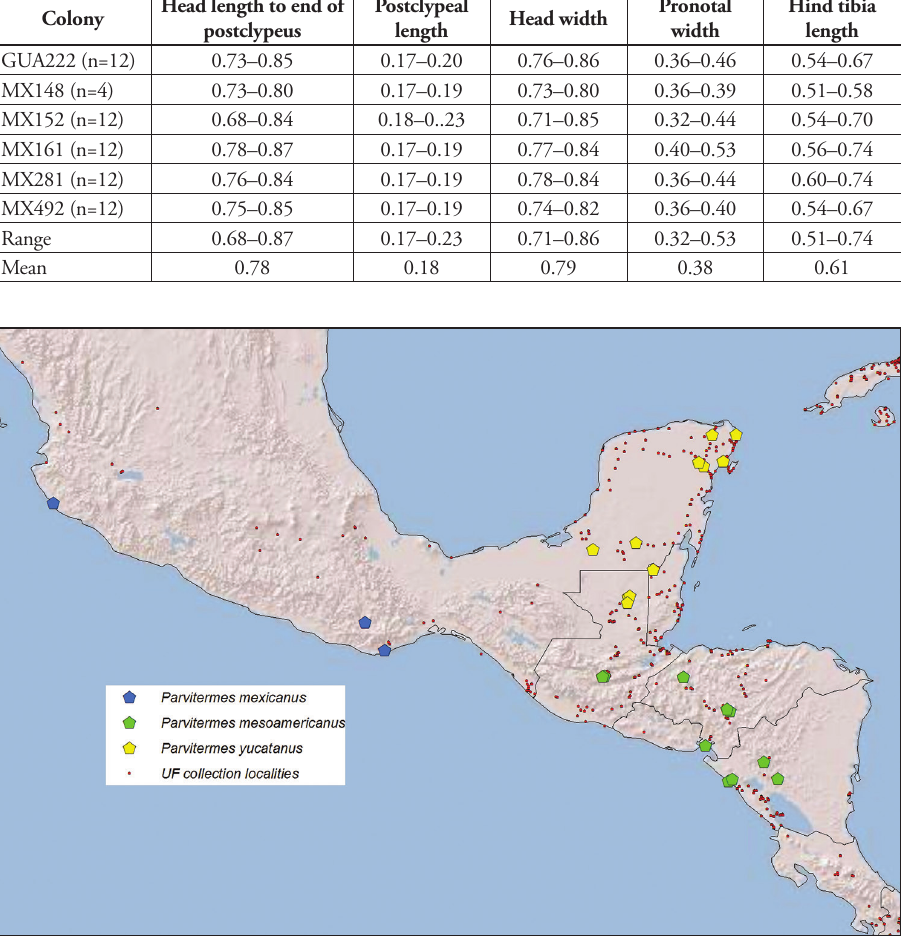
Figure 7. Collection localities of three Parvitermes species in the UF Termite collection. The far western sample of P. mexicanus comb. n. was taken near the type